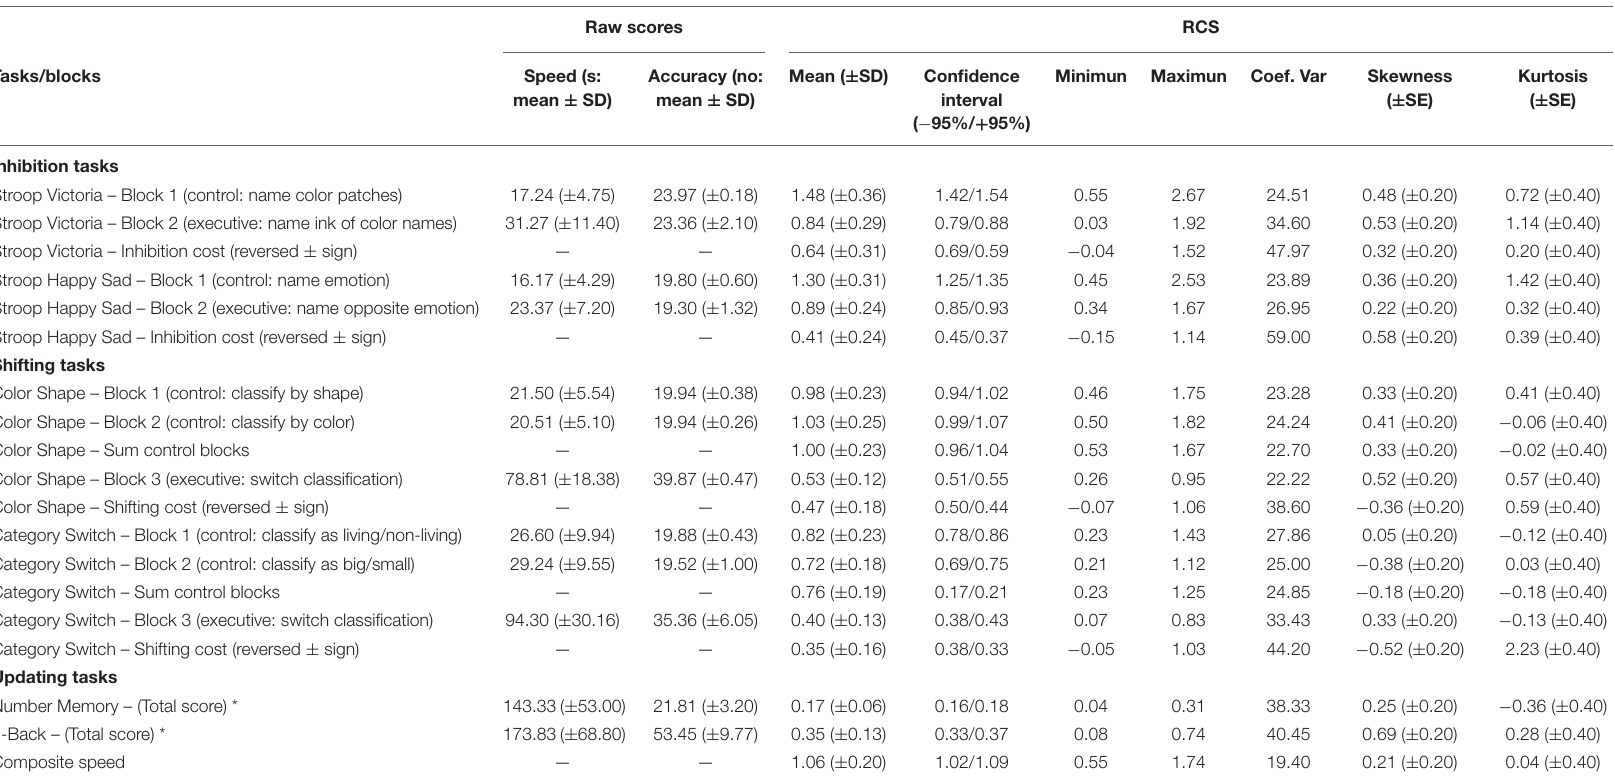
TABLE 2 | Descriptive statistics of raw score and Rate Correct Scores (RCS: accuracy divided by total time in seconds), expressed so that higher scores indicate better performance in all blocks per tasks and absolute executive costs (RCS of executive blocks minus RCS of control blocks) according to each executive domain. Tasks/blocks Speed (s: